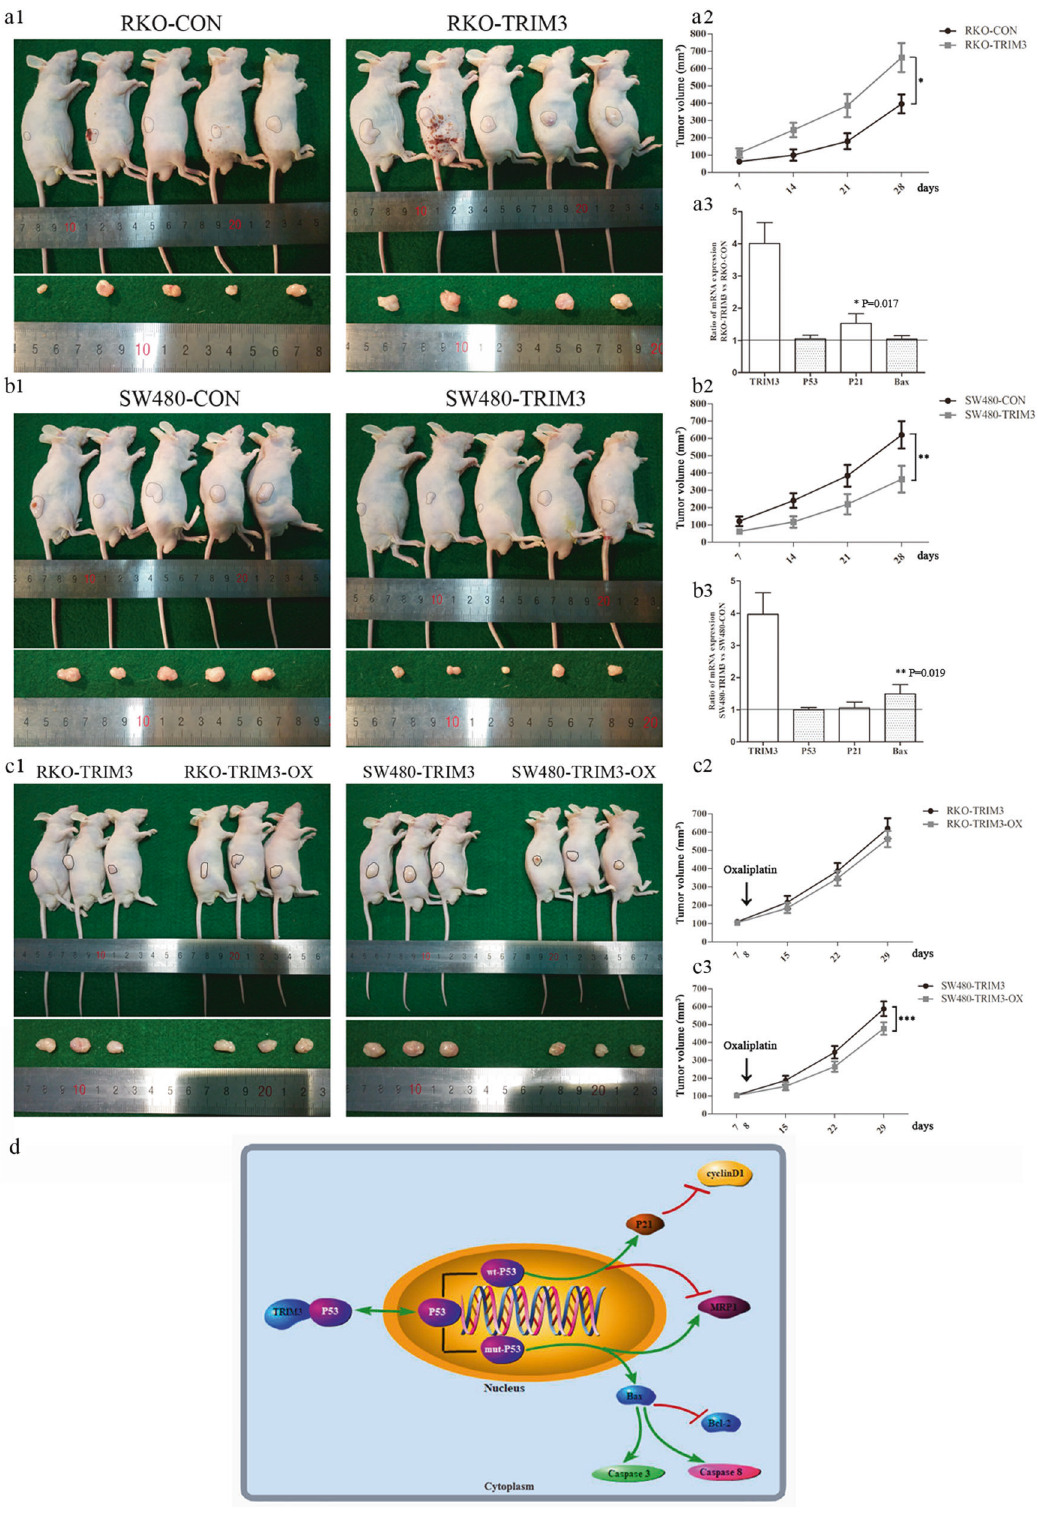
DISCUSSION P53, as a transcription factor, regulates a large number of diverse downstream genes to exert regulative function in multiple signaling processes. It is thought that p53 mutations play a critical role in the CRC adenoma-carcinoma transition process